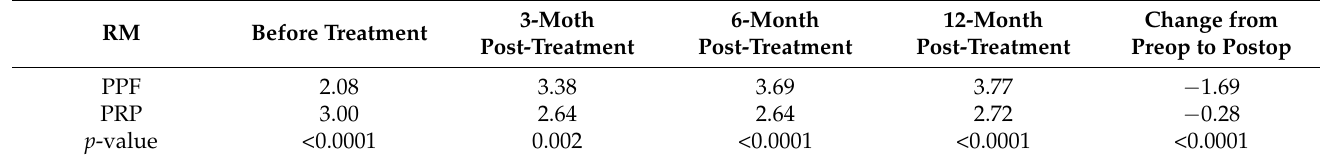
Table 2. Roles-Maudsley Scale (RM) between PRP to PPF